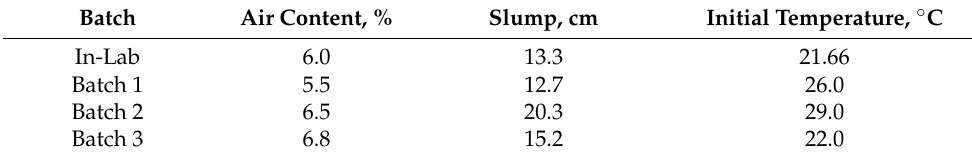
Table 2. Fresh concrete